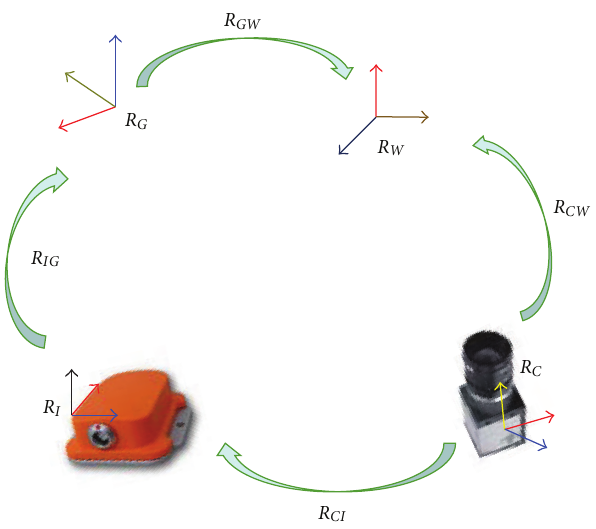
Figure 5: Inertial/Camera: Reference frames configuration.